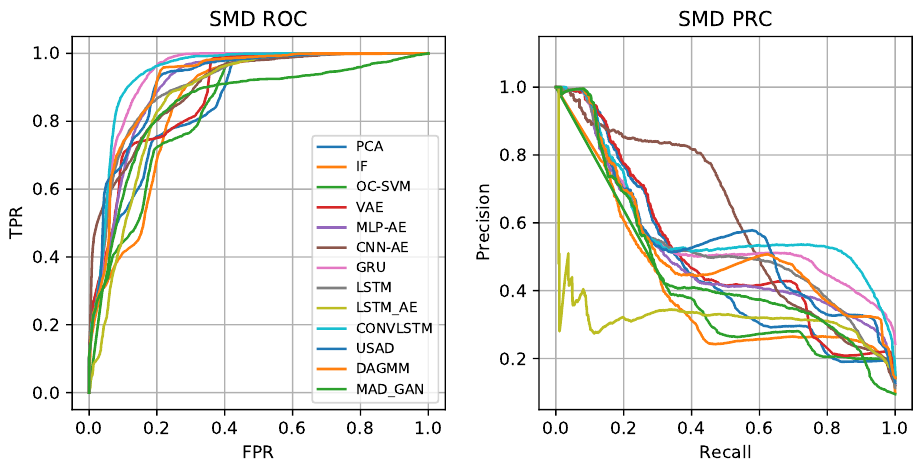
Figure 5. ROC and PRC for SMD